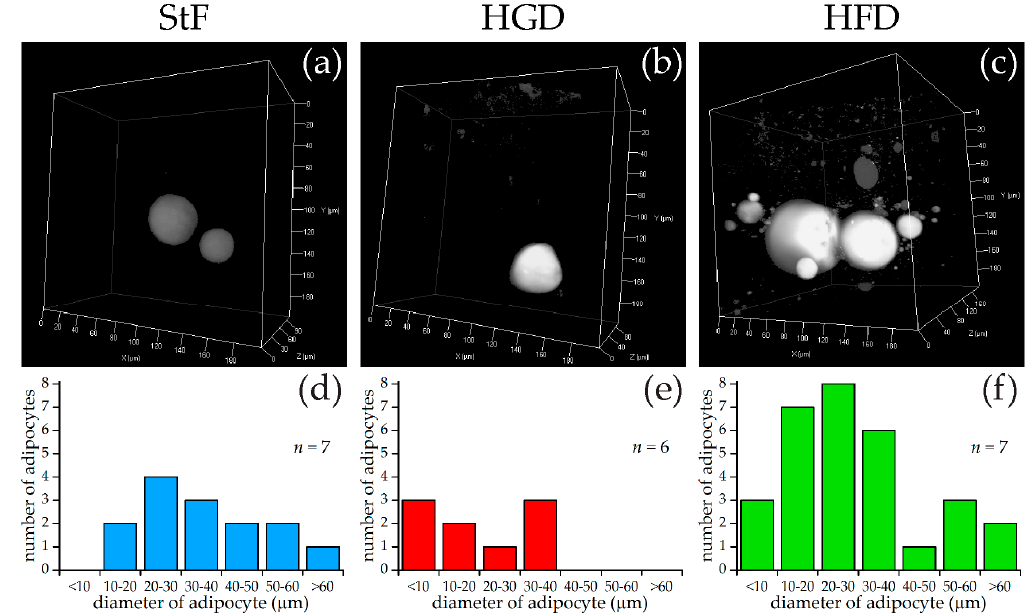
Figure 3. SRS imaging of adipocytes in zebrafish larvae exposed to different diets. ( a – c ) Representative images of volumes of SRS lipid measurements for standard diet (StF), high glucose diet (HGD) or high fat diet (HFD), respectively; ( d – f ) Frequency of adipocytes in different size classes following StF ( n = 7), HGD ( n = 6) and HFD ( n = 7) respectively, determined by an automated image processing algorithm in MATLAB.